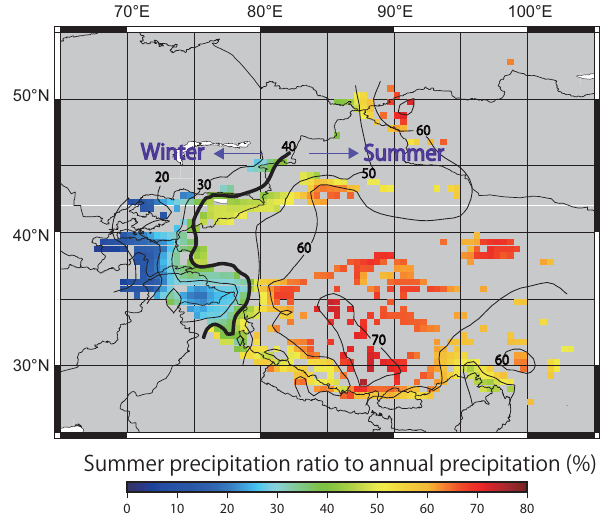
Figure 9. Distribution of summer precipitation ratio to annual pre- cipitation from APHRODITE data. Black thick line indicates the contour of the 40% summer precipitation